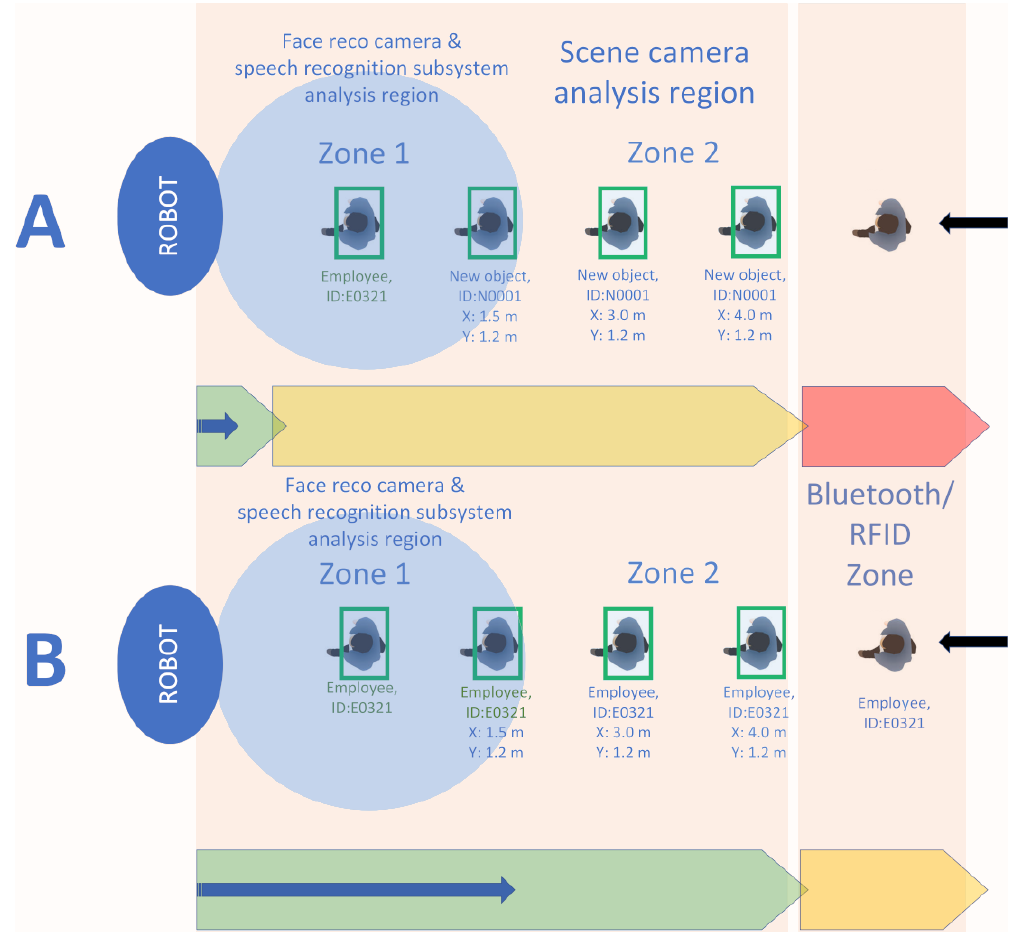
Figure 5. Comparison of mechanisms for obtaining information regarding interlocutor. Use case ( A )—no RFID or Bluetooth signals available. Use case ( B )—RFID UHF and Bluetooth subsystems are enabled. Red wide arrow means no information about incoming object/person, yellow wide arrow means partial information about object/person, green wide arrow means detailed information about object/person and blue narrow arrow means the possibility to start personalized interaction between robot (AI framework agent) and